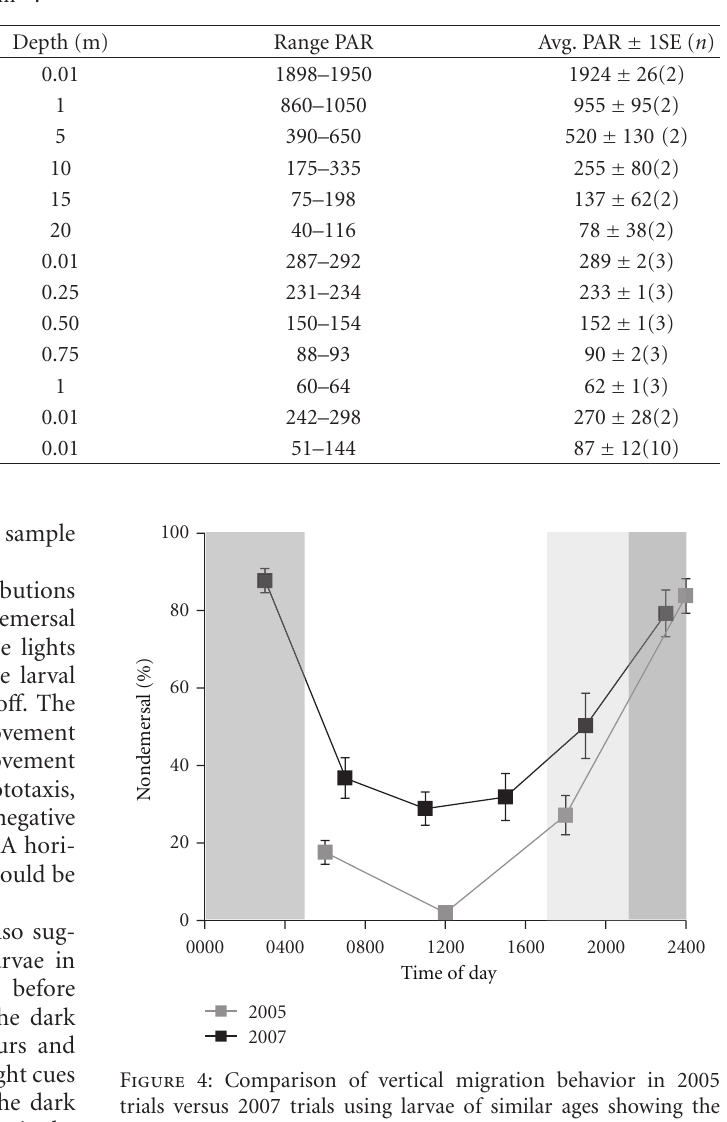
Table 3: Photosynthetically active radiation (PAR) measurements in the field during partial-sun to full-sun conditions and in laboratory culture columns. Treatments refer to tall (9.5d × 125 hcm) and short (9.5d × 15 hcm) column dimensions. Columns in the 2005 lab